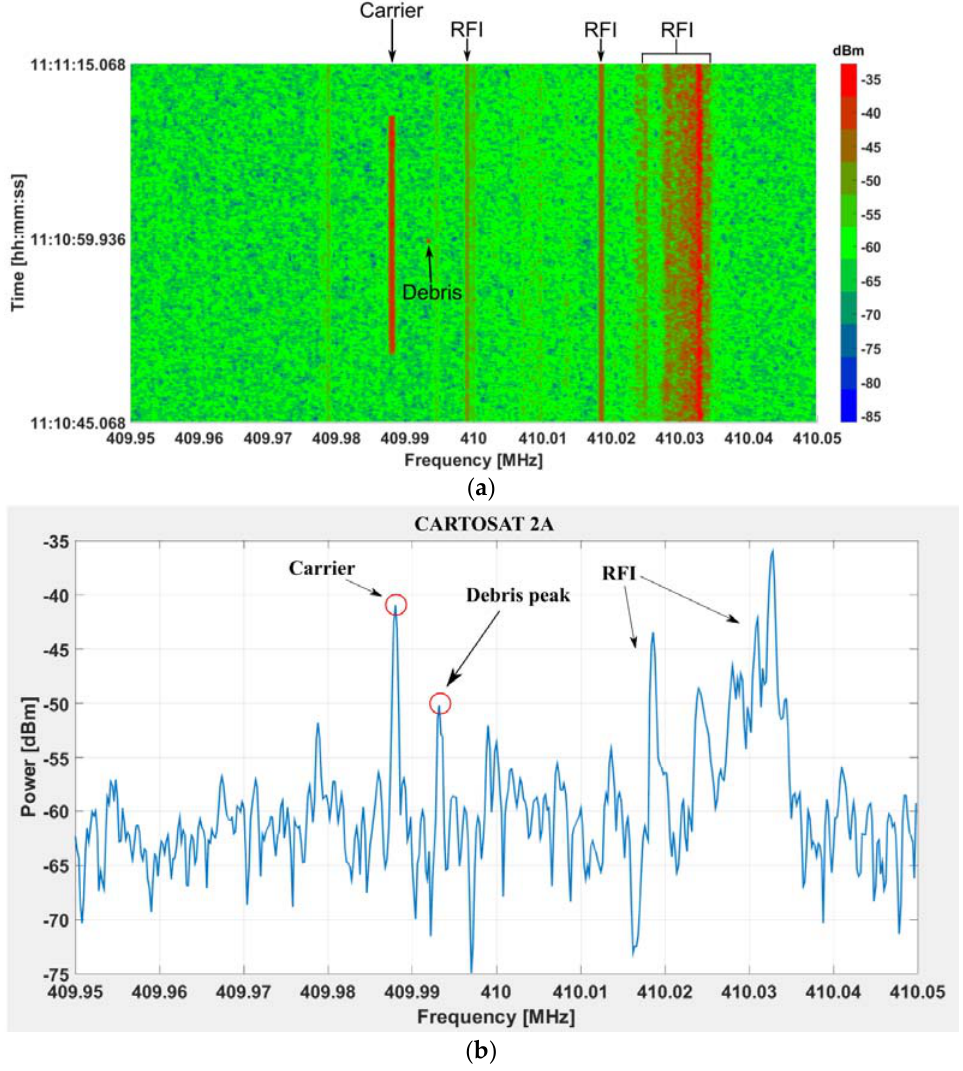
Figure 7. Debris CARTOSAT 2A: ( a ) spectrogram; ( b ) screenshot of the spectrum analyzer at the center of the visibility interval (Table 4).